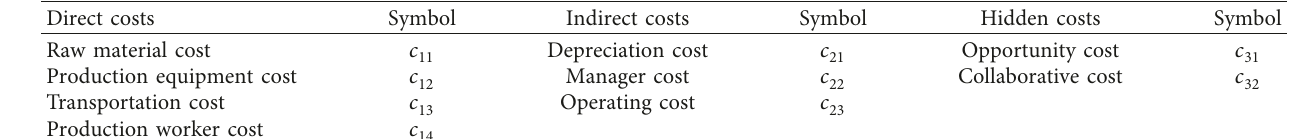
Table 2: Production input